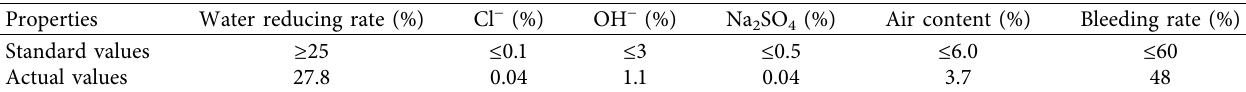
Table 3: Water reducer test report.